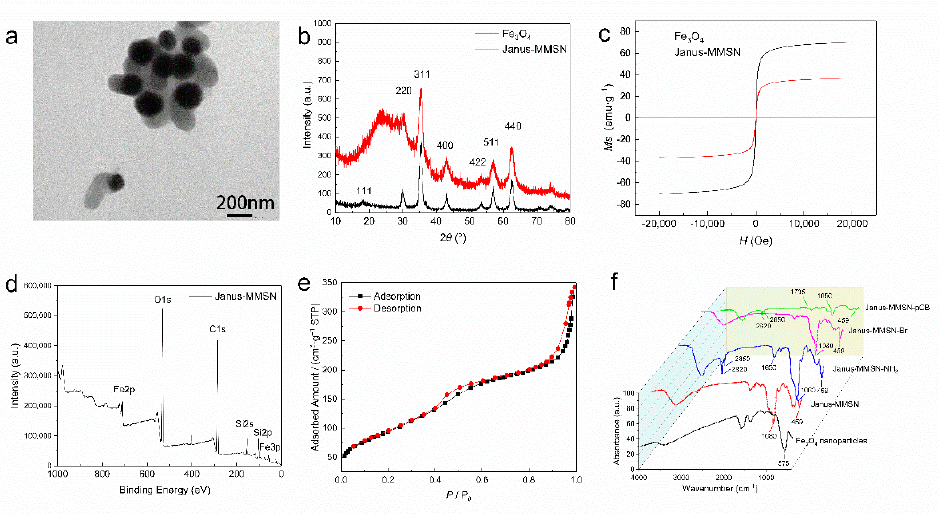
Figure 2. Preparation and characterization of Fe 3 O 4 nanoparticles and Janus nanovehicles. ( a ) TEM images of Janus-MMSN. ( b ) XRD spectra of Fe 3 O 4 nanoparticles and Janus-MMSN. ( c ) Magnetic hysteresis loops of Fe 3 O 4 nanoparticles and Janus-MMSN. ( d ) XPS spectra of